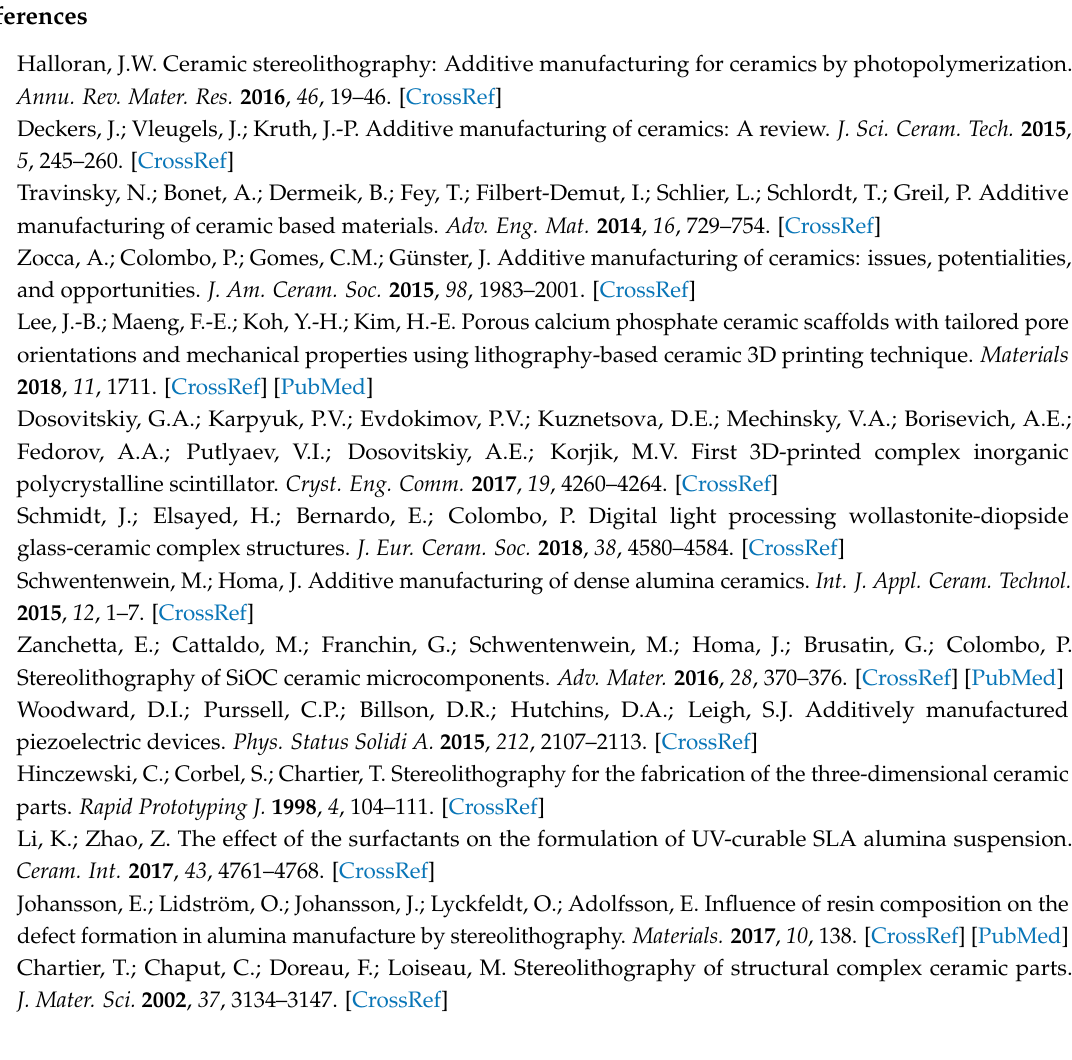
Table S1: Calculated power law parameters (dashed curves) for acrylate-based suspensions, Figure S1: SEM micrographs of green body derived from IBOA-TMPTA suspension (20 × and 100 × magnification), Figure S2: SEM micrographs of green body derived from IBOA-TMPTA suspension (20 × and 100 × magnification), Figure S3: SEM micrographs of 3YSZ ceramic derived from IBOA-TMPTA suspension (20 × and 100 × magnification), Figure S4: SEM micrographs of 3YSZ ceramic derived from IDA-TMPTA suspensions (20 × and 100 × magnification), Figure S5: SEM micrographs of green body derived from IBOA-TMPTA suspension with 25 µ m layer thickness and the fabricated 3YSZ ceramic, Figure S6: SEM micrograph of a Vickers indent of 3YSZ ceramic, Figure S7: Optical image of green and sintered bodies derived IDA-TMPTA